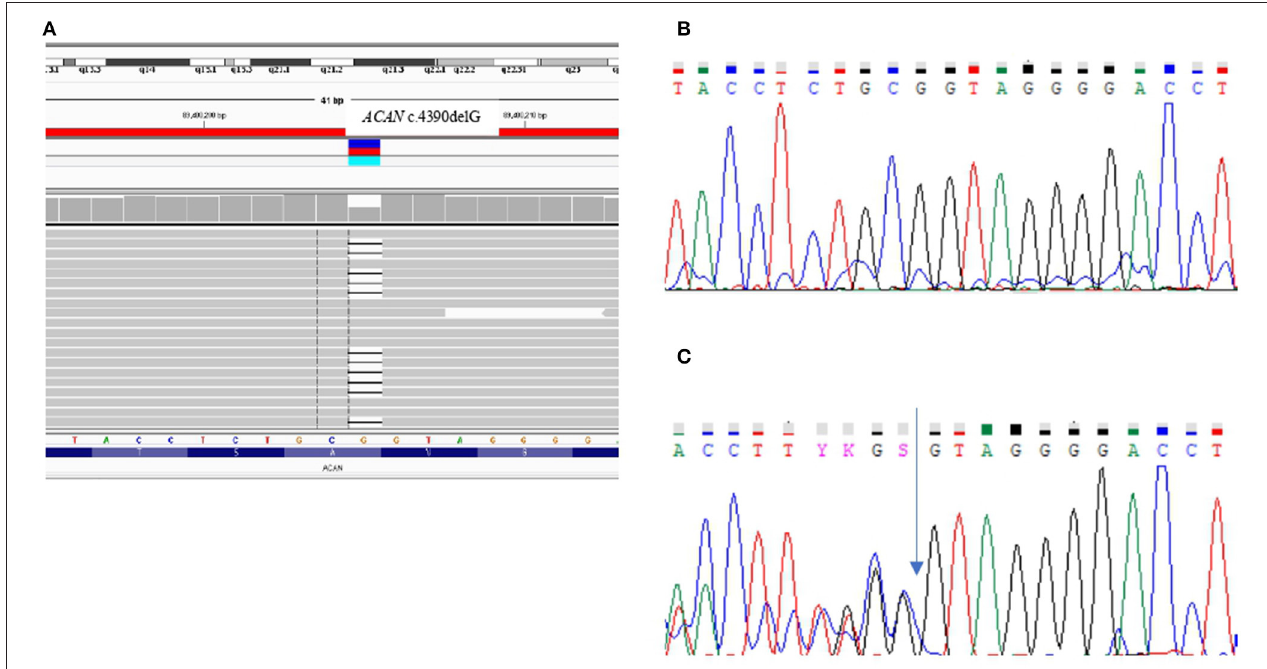
FIGURE 3 | Genetic analysis. (A) NGS file and (B,C) Sanger sequencing chromatograms reporting the wild-type (B) and the c.4390delG variant identified in the patients (C) in exon 12 (NM_013227) of the ACAN